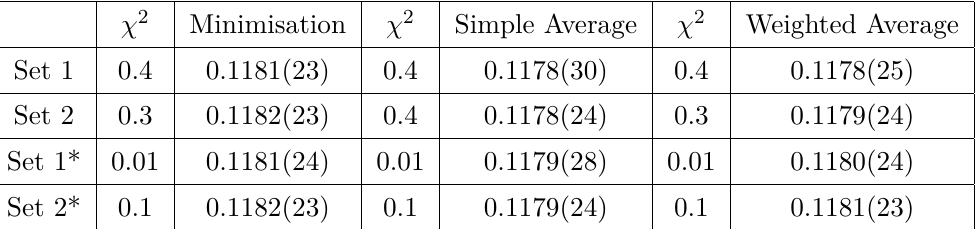
Table 12 . Averaged results for α ( n f =5) s ( M 2 variations are assumed to be uncorrelated.